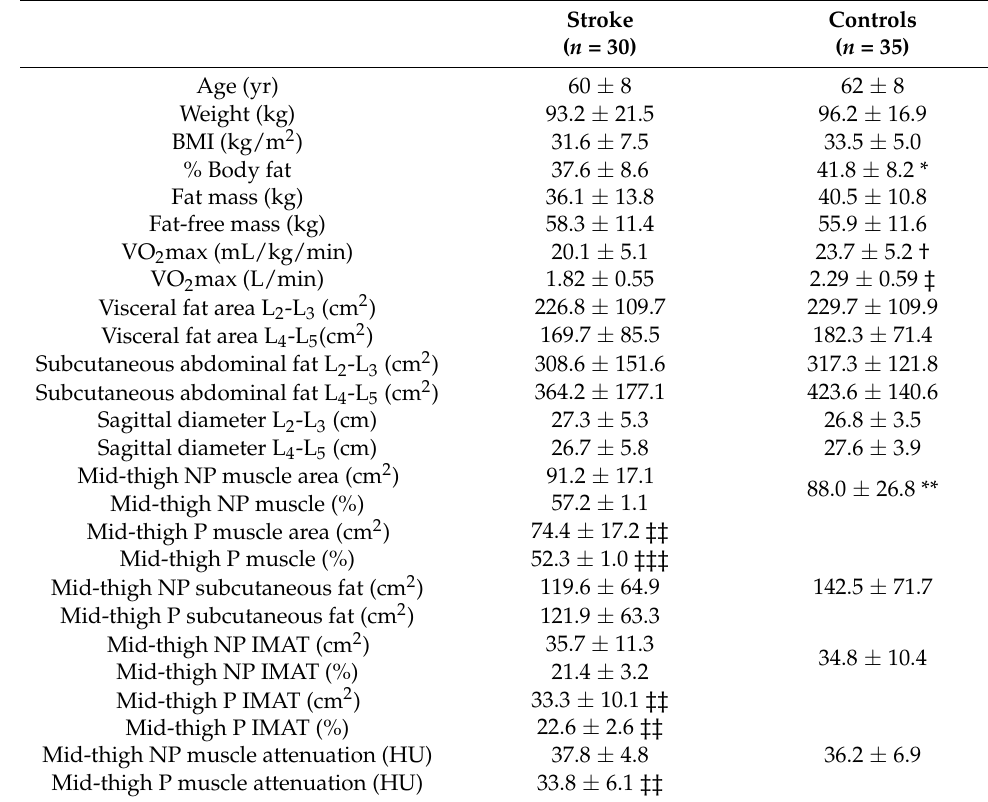
Table 1. Physical and metabolic